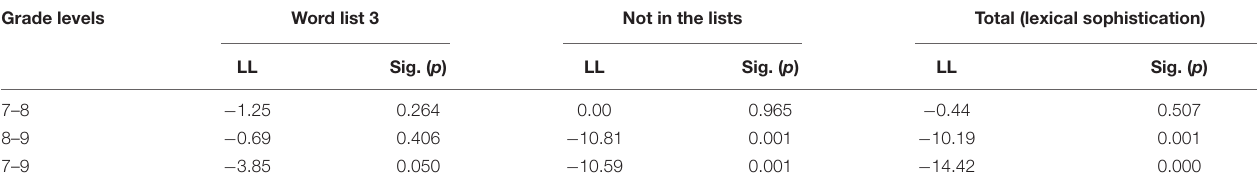
TABLE 2 | Log-likelihood (LL) tests for lexical sophistication across grade levels. Grade